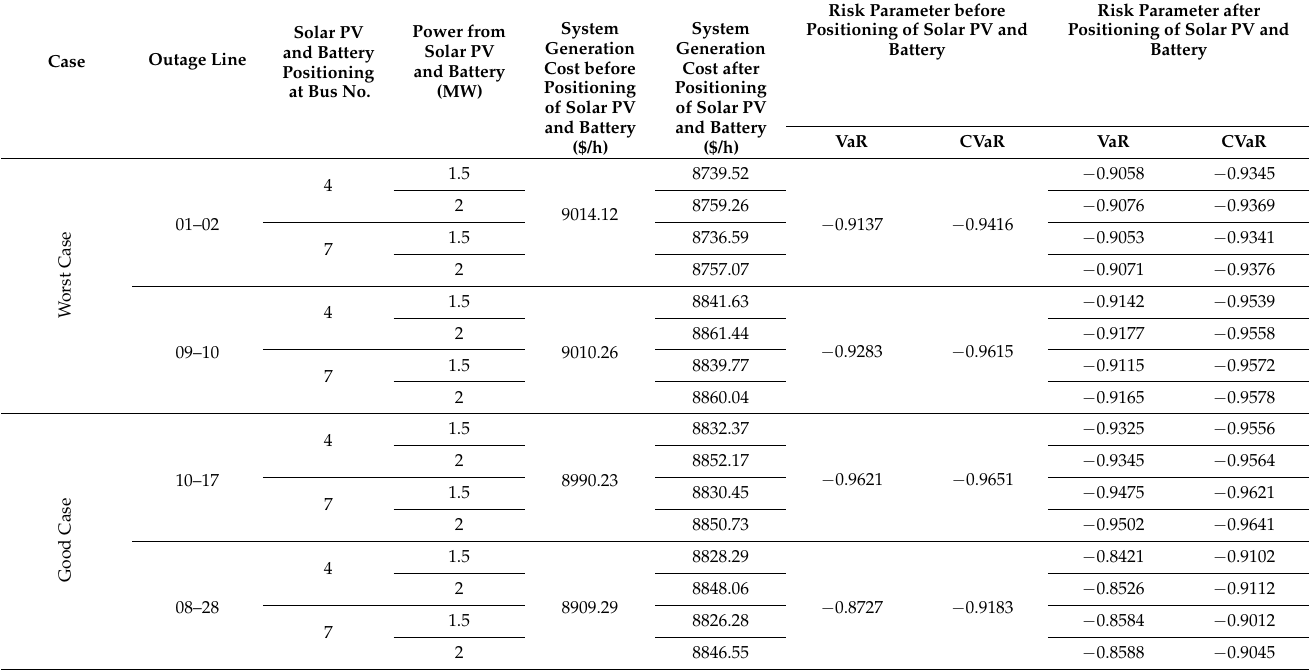
Table 8. VaR and CVaR after Installation of Solar PV and Battery in IEEE 30-bus System.